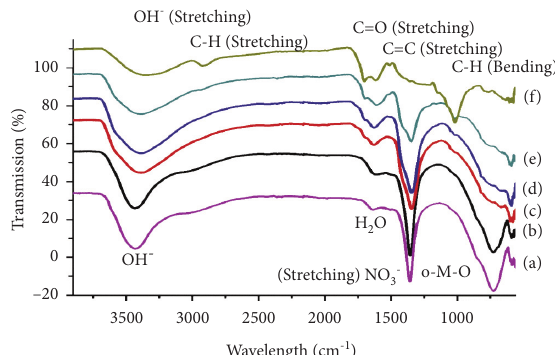
Figure 3: FTIR spectra LDH (a), C-1 (b), C-2 (c), C-3 (d), C-4 (e), and HC (f).